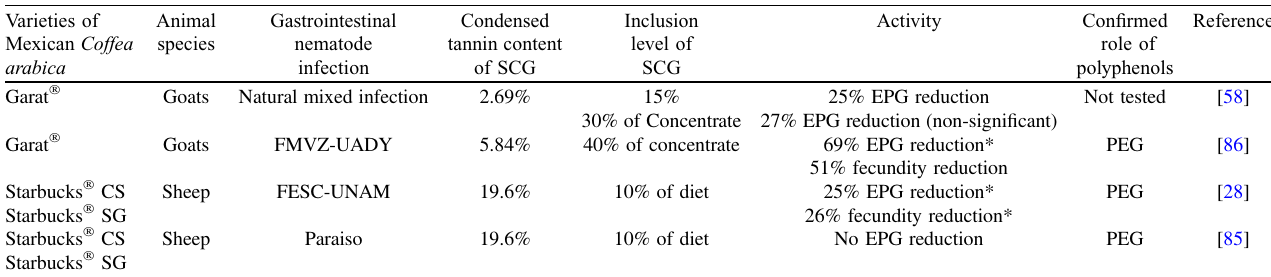
Table 2. In vivo anthelmintic activity against gastrointestinal nematode infections using different types of spent coffee ground (SCG) mixed within the feed of goats and sheep. The condensed tannin content of each extract (catechin equivalent) is also included, as well as the con fi rmation of the role of polyphenols in the in vivo activity using polyethylene glycol. Varieties of Mexican